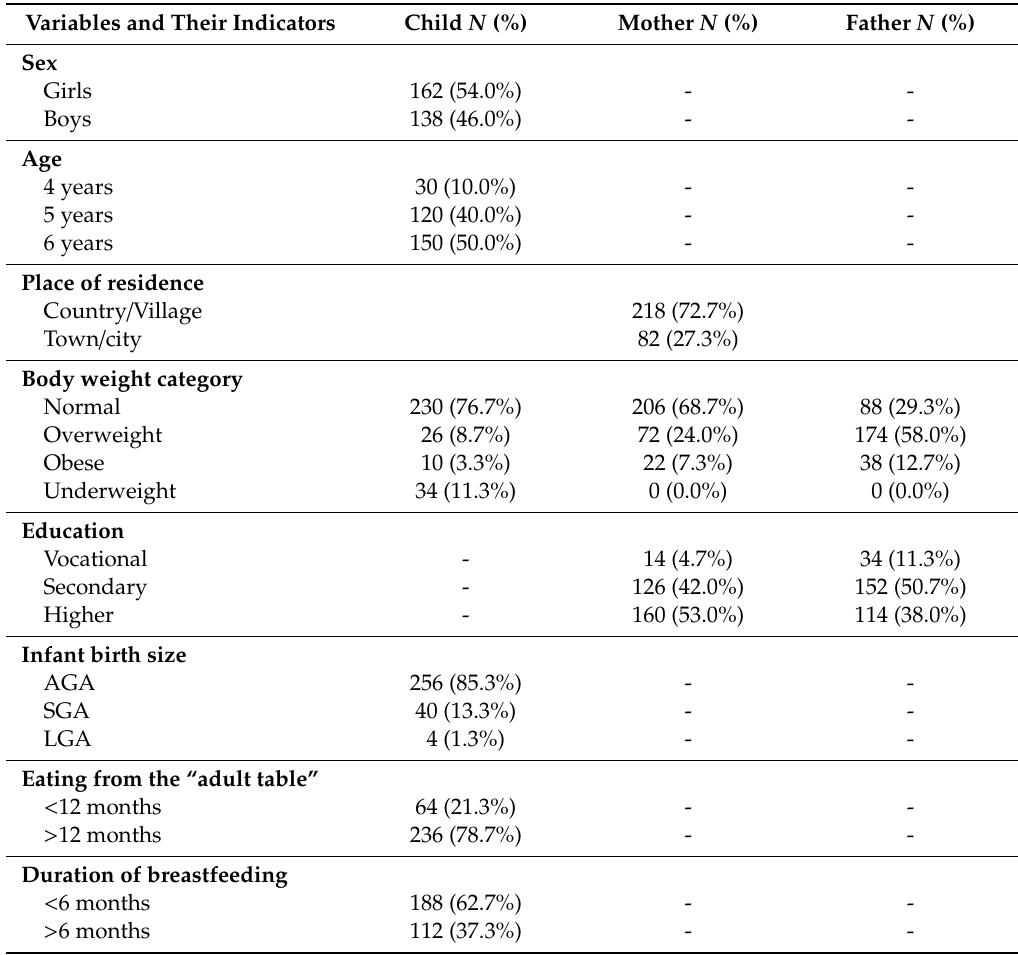
Table 1. Characteristics of the study group.